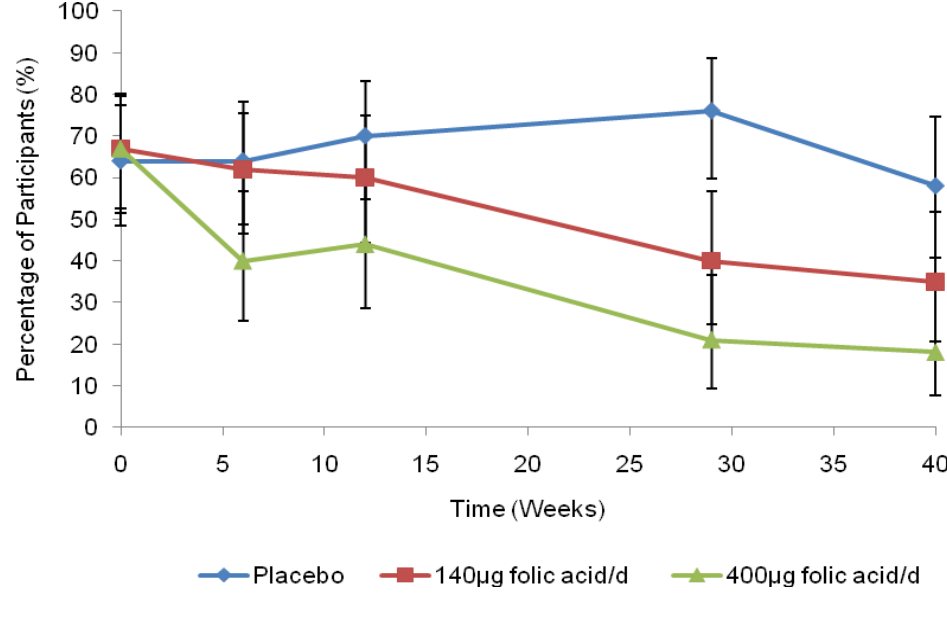
Figure 2. Unadjusted percentage of red blood cell folate concentrations <906 nmol/L (95%